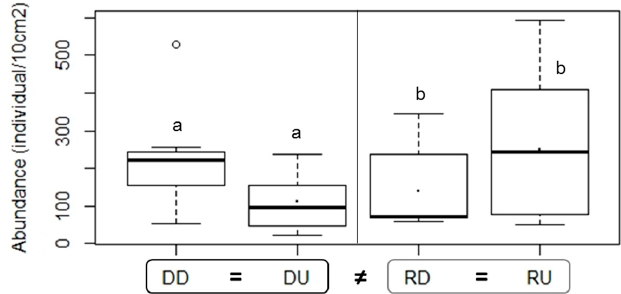
Figure 3. Box and whisker plots and mean values (.) for heavy metals including Fe ( A ), Cu ( B ), Cr ( C ), Hg ( D ), Se ( E ), Pb ( F ), As ( G ), Cd ( H ), H 2 S ( I ) and CH 4 ( J ) concentration in sediment of the estuarine sections. point to estuary level. Abbreviations: “DD” = dammed downstream, “DU” = dammed upstream, “RD” = reference downstream, “RU” = reference upstream. Letters a and b pointed to significant differences. “ ≠ ” sign indicated for the significant differences between 2 estuaries, while “=” sign